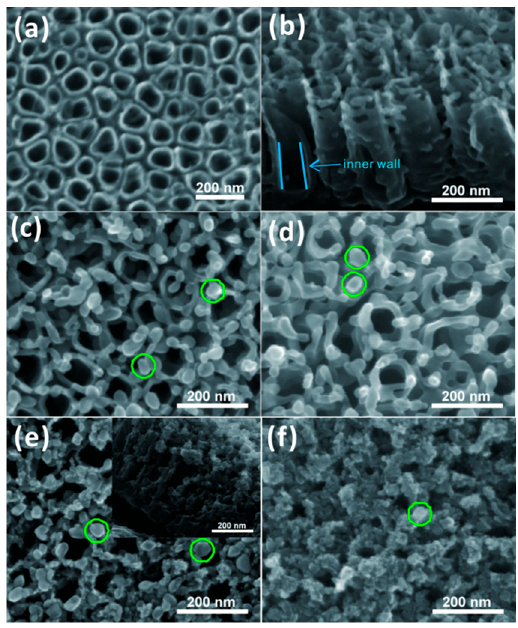
Figure 1. ( a ) Top and ( b ) side view SEM images of TiO 2 nanotube arrays (TNTs). Top view SEM images of LaFeO 3 nanoparticle-modified TNTs (LFO/TNTs) prepared by hydrothermal deposition for ( c ) 8 h, ( d ) 10 h, ( e ) 12 h, and ( f ) 14 h (green circles indicate LFO nanoparticles).